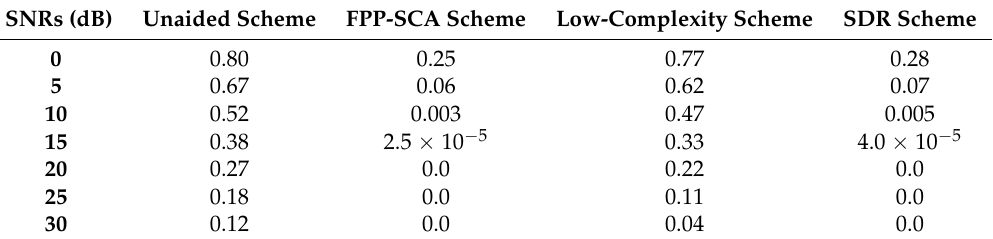
Table 3. The BER performance for different schemes when M = 2, N =